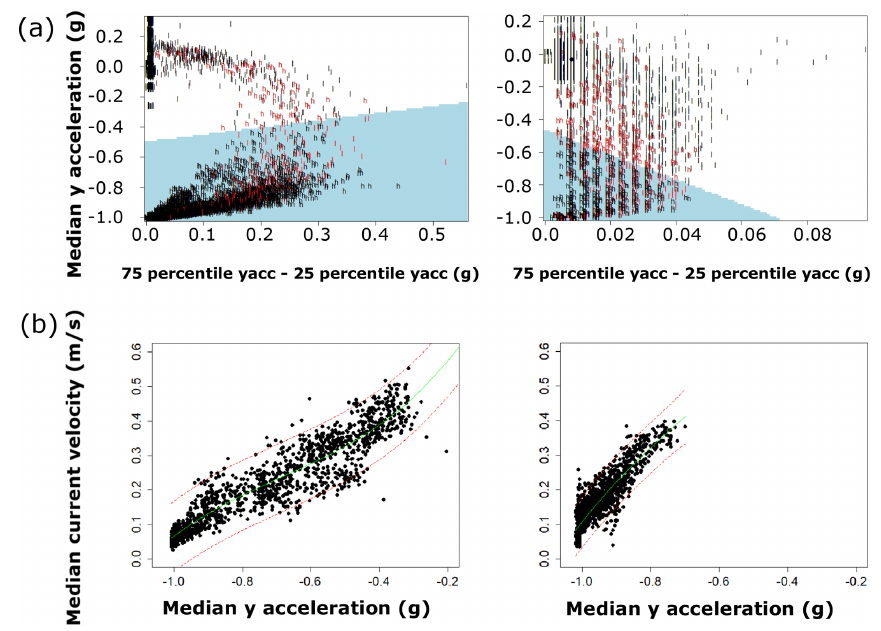
Figure 3. Training data for the Mini Buoy calibration at both study sites. (a) Linear discriminant analysis (LDA) with prediction of flooded and non-flooded time steps of L2–L5 (Bay of Fundy, left) and B9, B11, B12, and B14 (North Sumatra, right) based on acceleration data and validated against measured water levels. The error rate of the LDA for the Bay of Fundy was 0.008 and for North Sumatra 0.015 (l is low tide, h is high tide, and red letters are false predictions). The blue-shaded area indicates the range of values for which inundation is predicted by the LDA. The LDA was then used to predict inundation events for all Mini Boys. (b) Polynomial regression provided the best fit for the median y -axis acceleration [ Y acc (g)] against the measured current velocity [ V cur (ms − 1 )] for 1min intervals at both study sites. L1 Bay = 0 . 84, P < 0 . 05; B1 North Sumatra: function of Fundy: V cur = Y acc 0 . 8812 + ( 1 . 9209 · Y acc ) + (( 2 . 1394 ) · Y acc2 ) + (( 1 . 0344 ) · Y acc3 ) , R 2 adj = 0 . 79, P < 0 . 05. Dotted red lines show the 95% prediction V cur = Y acc 1 . 488 + (( 2 . 893 ) · Y acc ) + (( 2 . 921 ) · Y acc2 ) + (( 1 . 410 ) · Y acc3 ) , R 2 adj intervals. Note that the Mini Buoy design differs slightly between both case studies as the Bay of Fundy design has an additional temperature and light logger